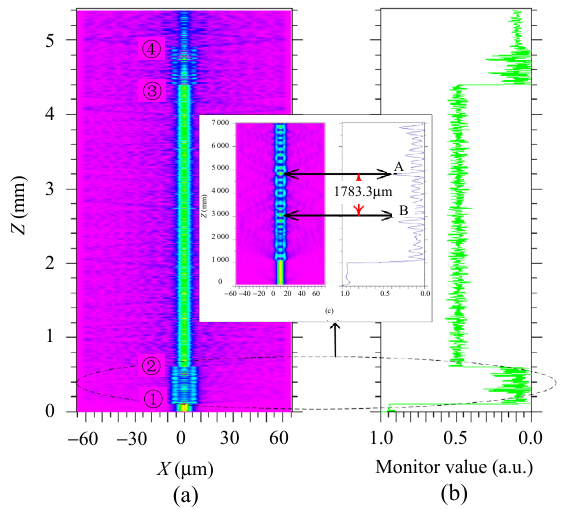
Fig. 3 Interference process in this MZI: (a) field evolution, (b) normalized power along the CSC, and (c) a larger version of the SMF-CMECF structure.